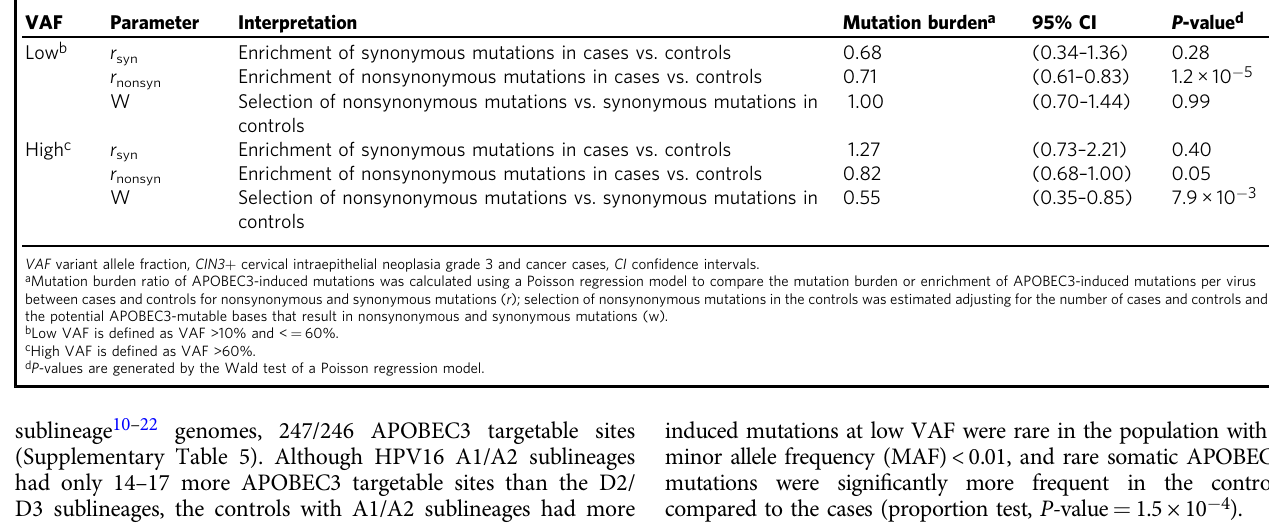
Table 3 Burden of APOBEC3-induced mutations in cases and controls from the NCI-Kaiser PaP cohort. Mutations are compared in CIN3 + cases vs. controls and for nonsynonymous (nonsyn) vs. synonymous (syn) mutations by variant allele